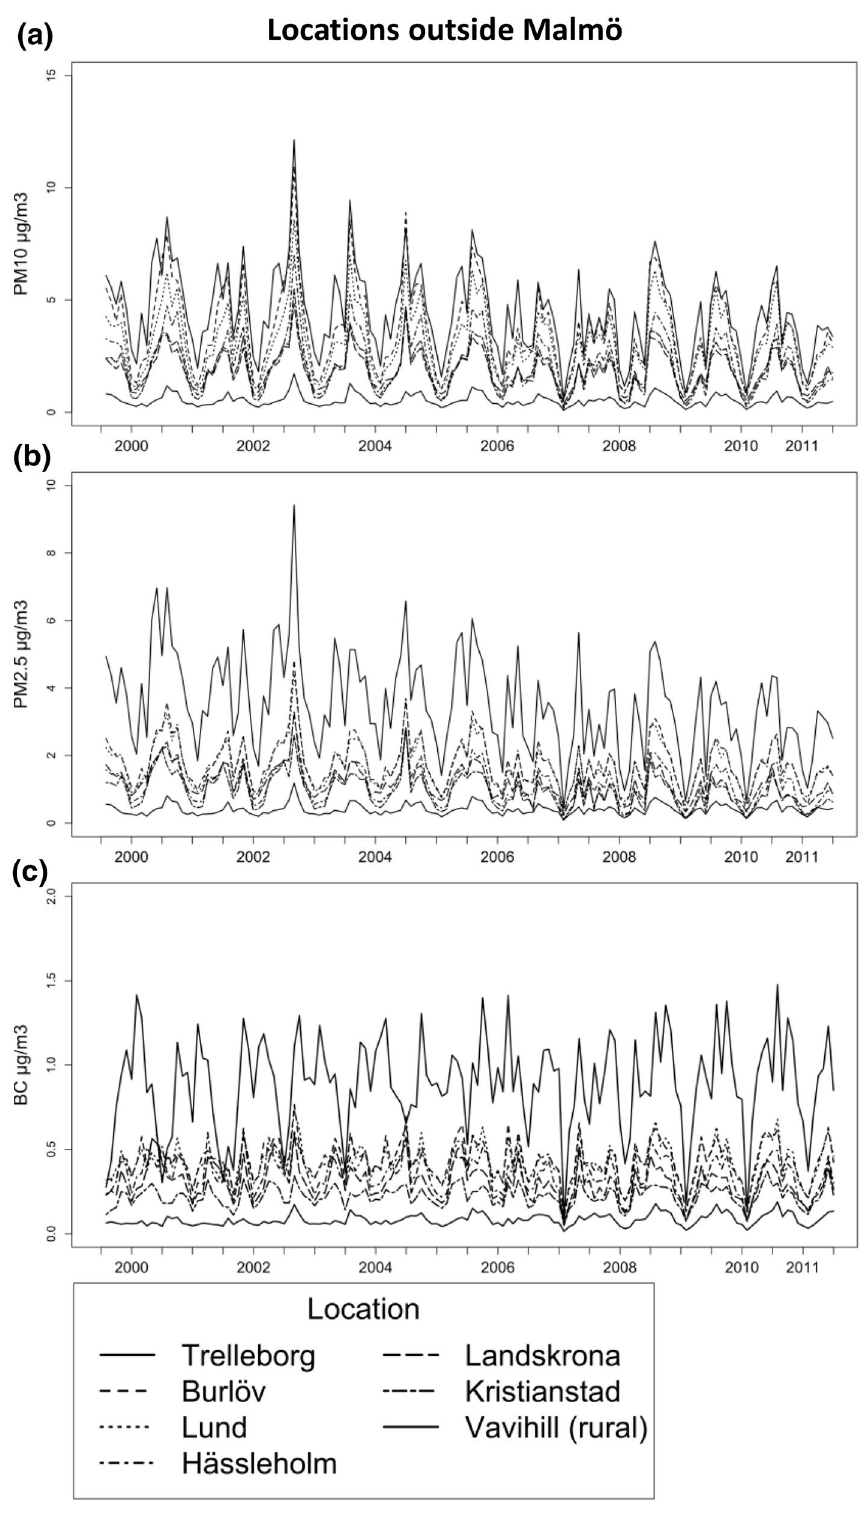
, b PM and 10 2.5